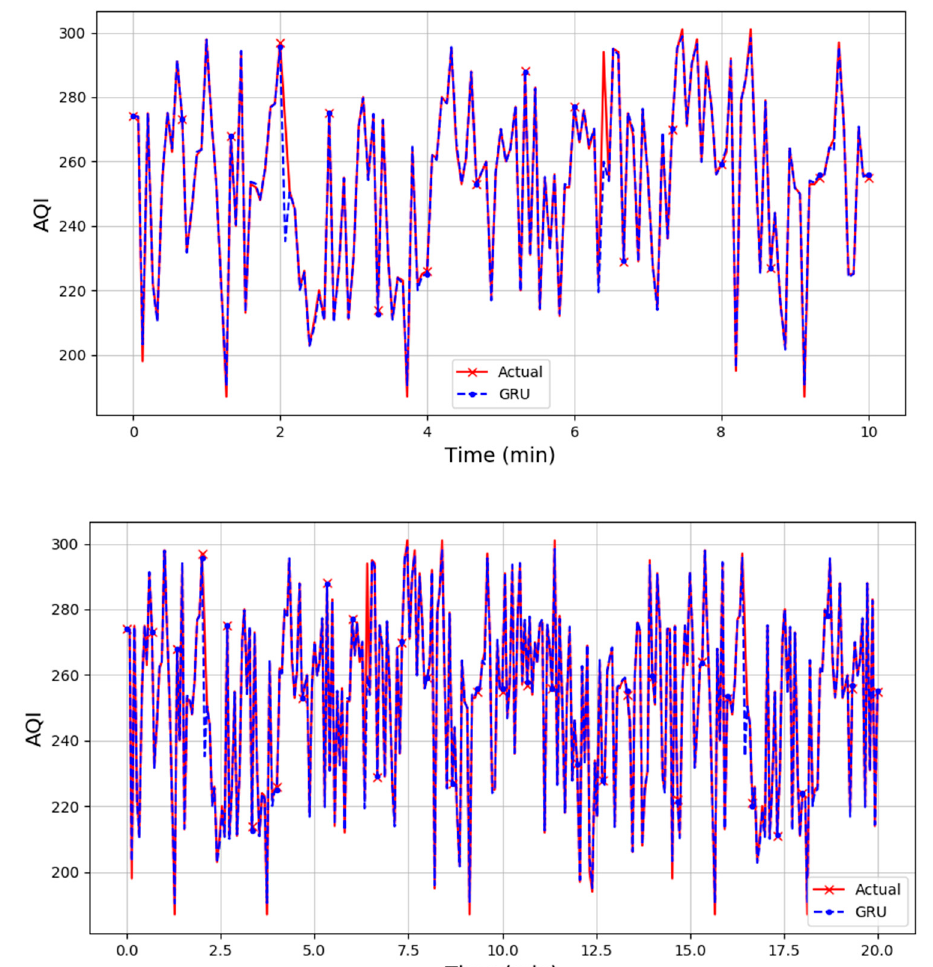
Figure 8. Comparison of Prediction Results using GRU Prediction Model with Actual Data.